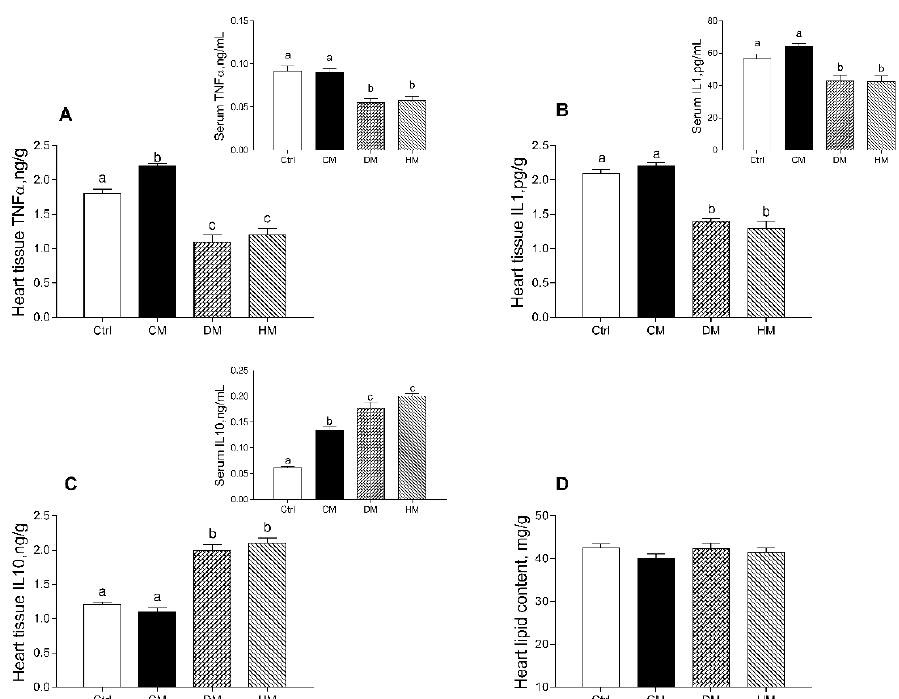
Figure 2. Cow milk (CM), donkey milk (DM) or human milk (HM) diet supplementation differently modulates inflammation in rat serum and cardiac tissue. Proinflammatory cytokines, such as tumor necrosis factor (TNF- α ) ( A ) and interleukin-1 (IL-1) ( B ) and anti-inflammatory marker interleukin-10 (IL-10) ( C ) were measured in serum and heart (upper panels). Total lipid content ( D ) was determined in heart tissue. Data were expressed as the means ± SEM n = 7 animals/group. Different letters (a,b,c) on top of the bars indicate statistically significant differences ( p < 0.05) among groups.